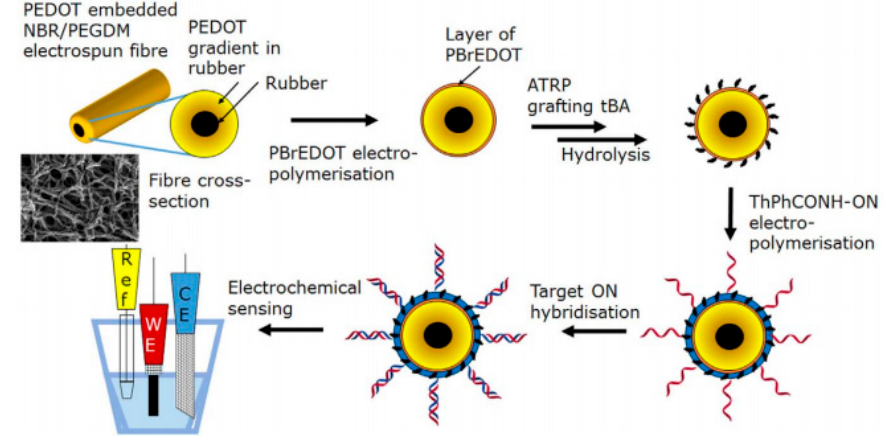
Figure 5. The fabrication of the PEDOT gene sensor using electrospun films [140]. Reprinted from The